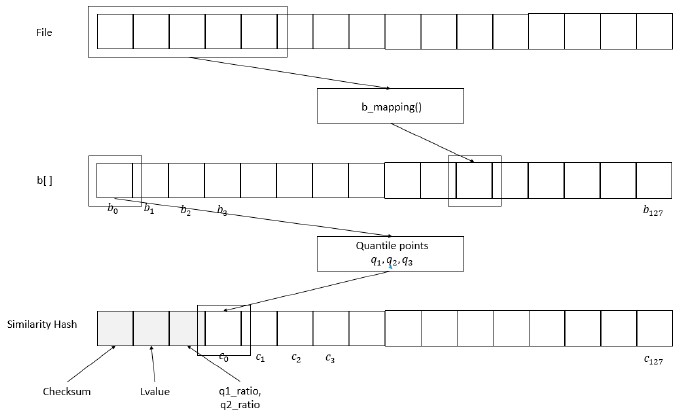
Figure 2. TLSH. Figure 2.